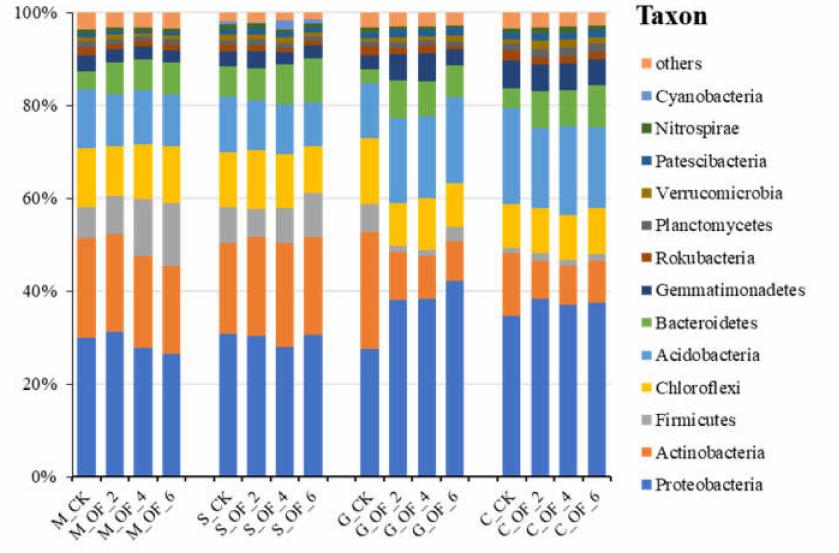
Figure 3. The relative abundance of bacterial level in different treated soil (phylum level). *M represents seedling stage, S represents three-leaf stage, G represents filling stage, C represents mature